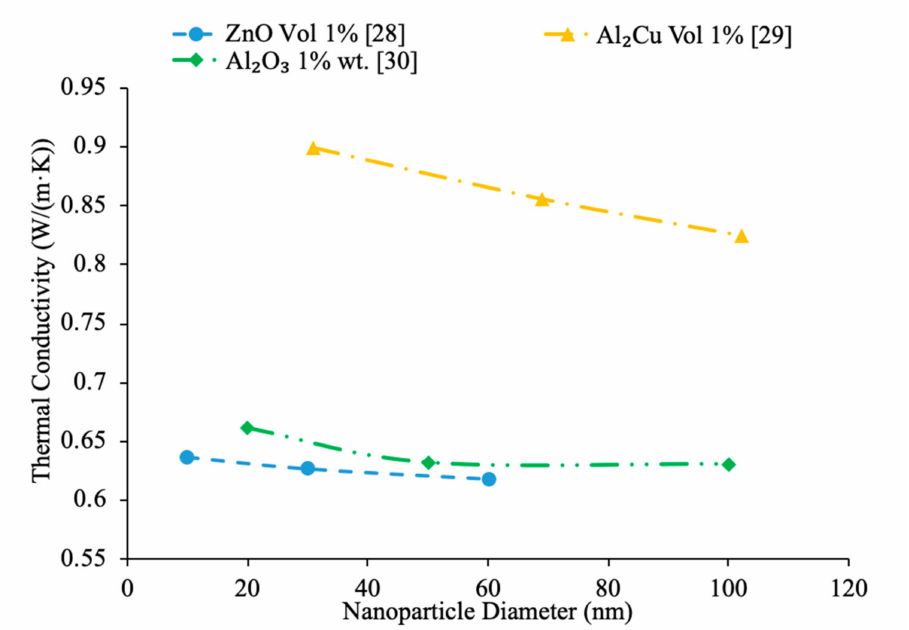
Figure 5. Thermal conductivity of water-based SiO 2 , Al 2 O 3 , and TiO 2 nanofluids at 1% volume fraction as a function of nanoparticle diameter